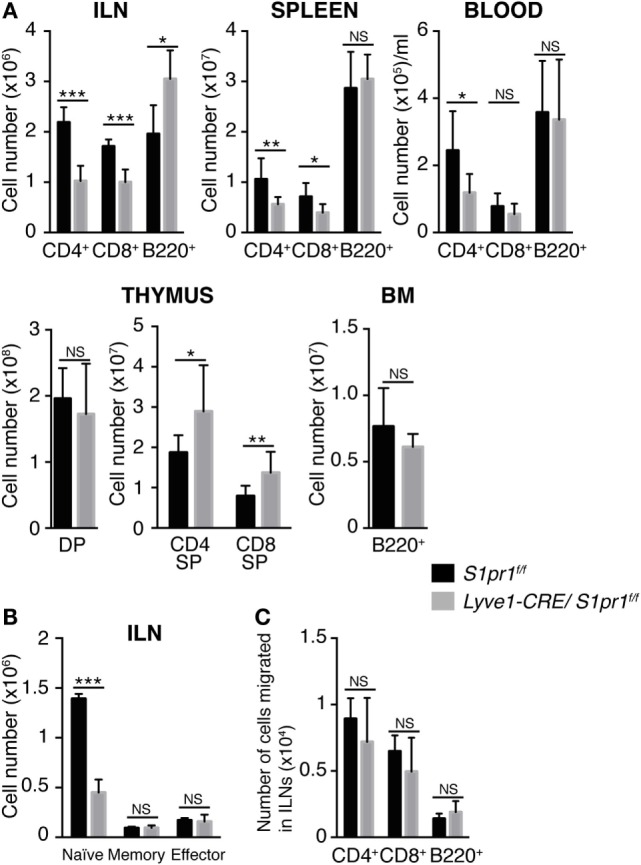
T cells are remarkably decreased in the peripheral lymphoid tissues of Lyve1-CRE/S1pr1f/f mice. (A) T and B cell numbers in the inguinal LNs (ILNs), spleen, blood, thymus, and bone marrow (BM) of S1pr1f/f and Lyve1-CRE/S1pr1f/f mice. DP, CD4+CD8+ double positive cells; CD4 or CD8 SP, CD4+ or CD8+ single-positive cells. (B) Numbers of CD4+ T cell subsets in the inguinal LNs of S1pr1f/f and Lyve1-CRE/S1pr1f/f mice. Naïve, memory, and effector CD4+ T cells were defined as CD62L+CD44−, CD62L+CD44+, and CD62L−CD44+, respectively. (C) Migration of WT lymphocytes into the LNs of S1pr1f/f and Lyve1-CRE/S1pr1f/f mice. Lymphocytes from beta-actin-eGFP mice were injected intravenously into recipient mice. After 12 h, the inguinal LNs were collected, and donor-derived lymphocytes were quantified by flow cytometry. These data are pooled from three independent experiments (n > 4) (A) and are representative of two (B,C) independent experiments with three mice per group. These data were evaluated by Student’s t-test and represent the mean ± SD (*P < 0.05, **P < 0.005, and ***P < 0.0005).